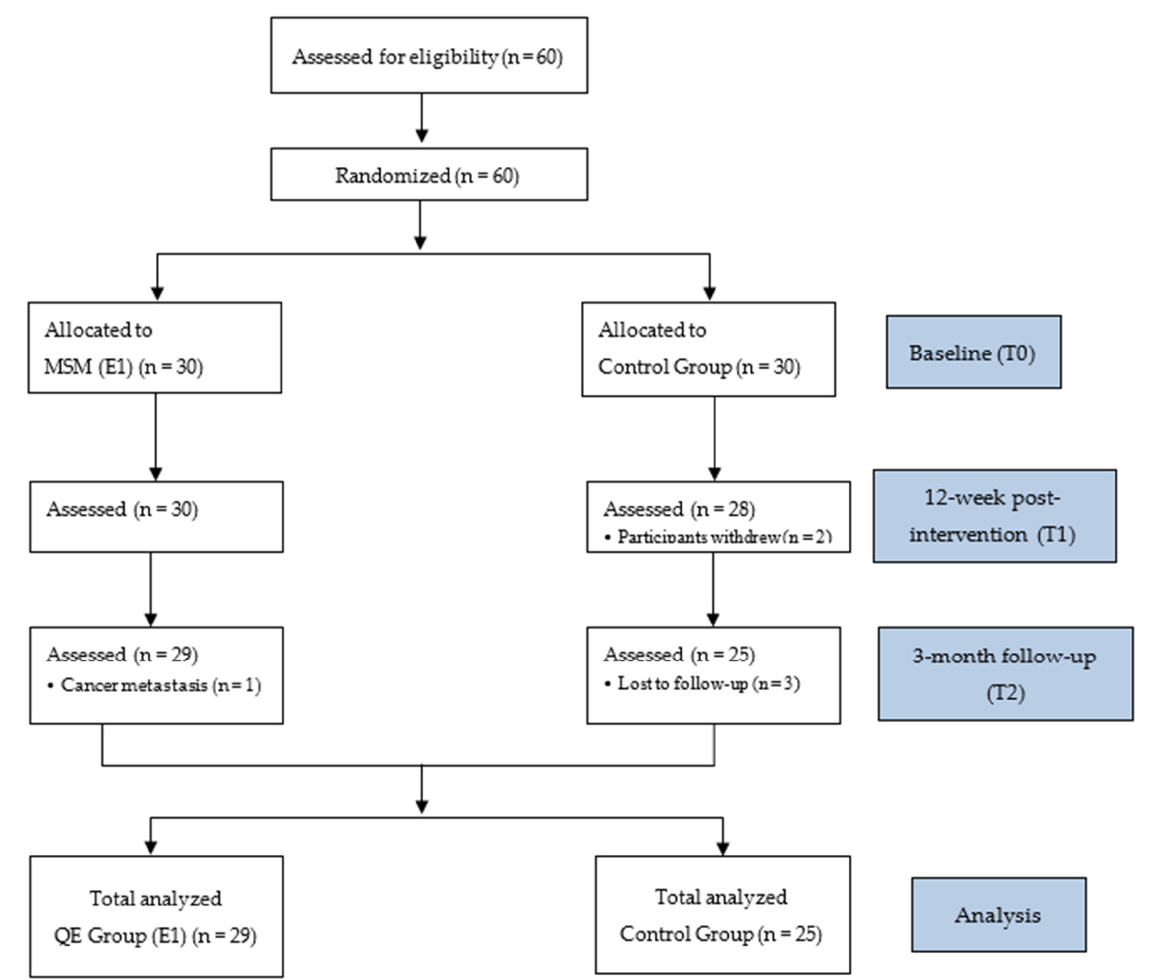
Figure 1. CONSORT flow diagram of this study.